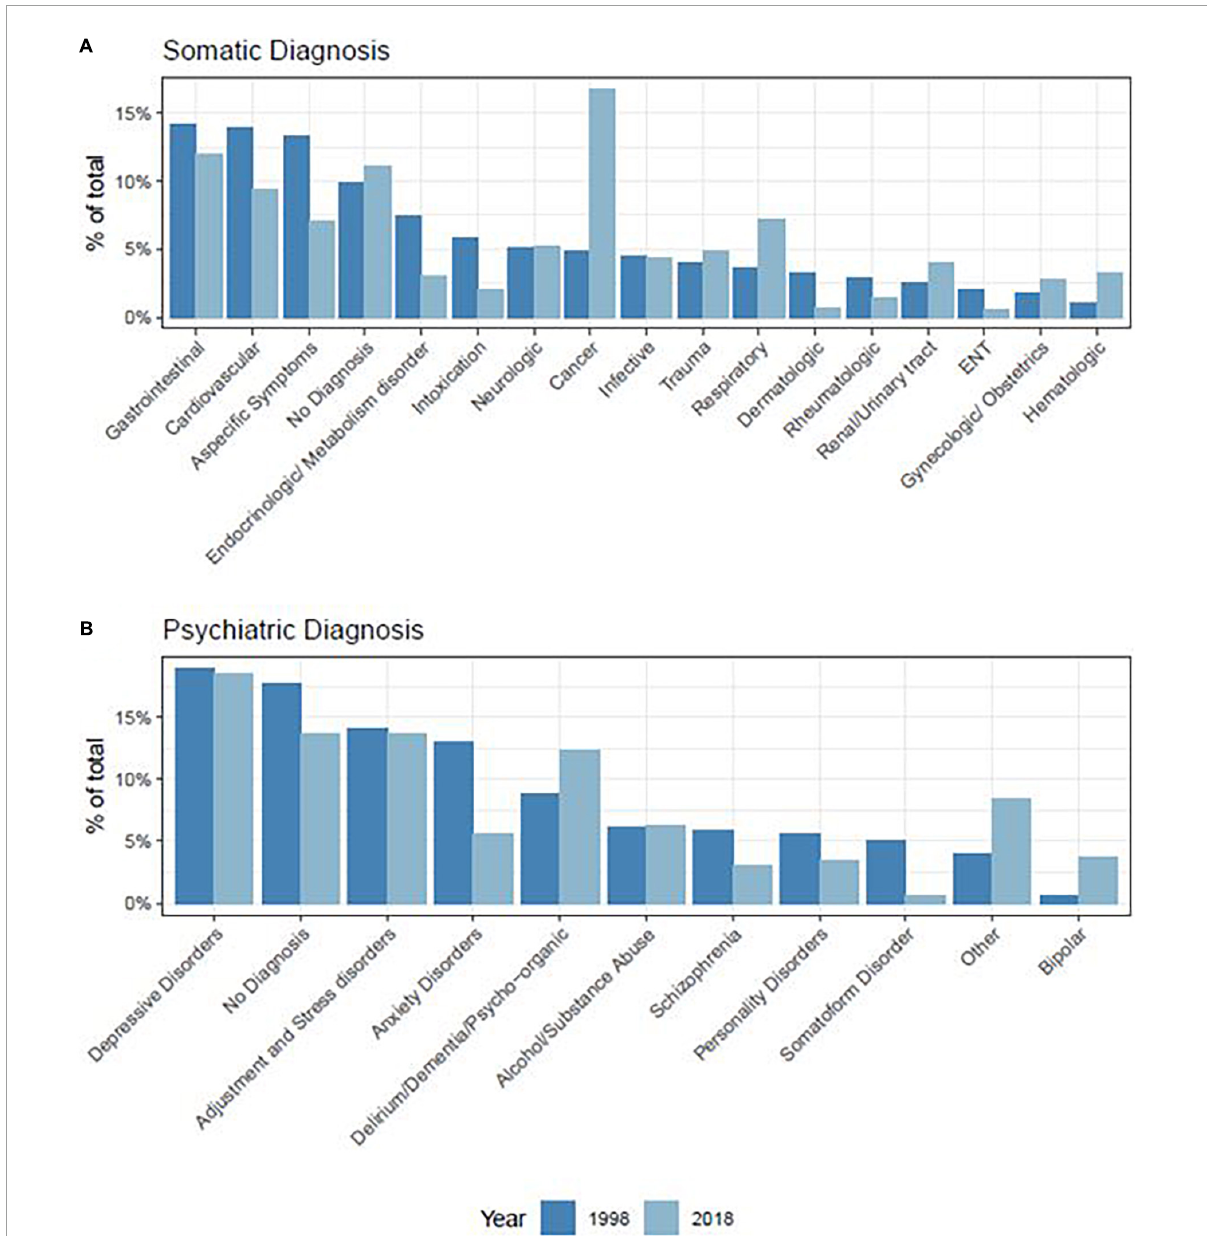
FIGURE1 Percentage of somatic (A) and psychiatric (B) diagnoses of referred patients.